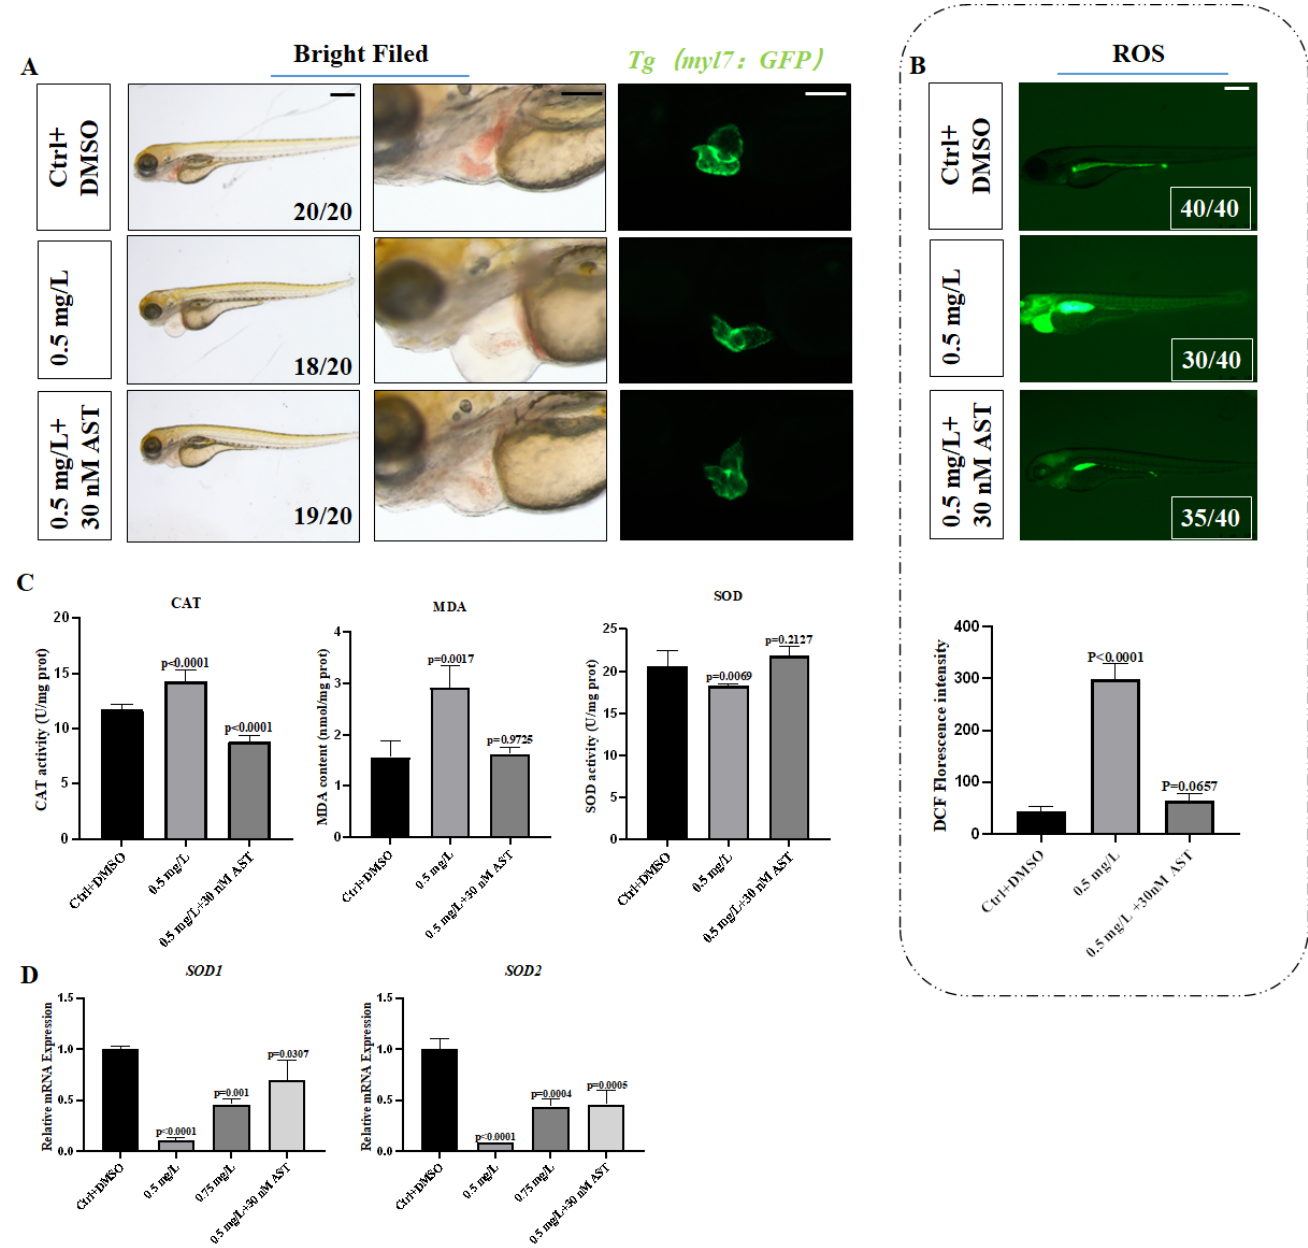
Figure 4. Astaxanthin rescued the oxidative stress caused by PCNB. ( A ). Bright field phenotypes and heart fluorescence images of the control group, medium concentration group, and AST rescue medium concentration group. ( B ). ROS-stained image of AST rescue. ( C ). MDA content, CAT activity, SOD activity. ( D ). Oxidative stress related gene expression level. Each difference is a comparison between the control group and the treatment group. ( n = 3, Means ± SD. Scale bar: ( A ) 500 µ m/100 µ m. ( B ) 500 µ m.).